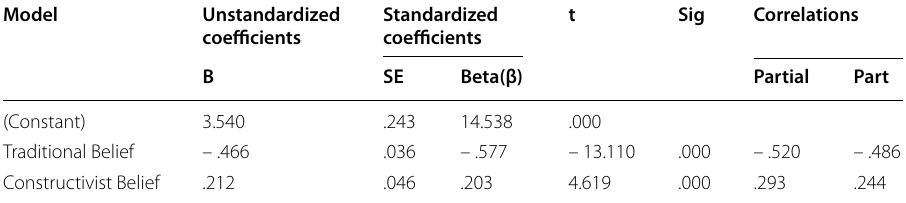
Table.8 Multiple regression analysis for predicting teachers’ constructive classroom